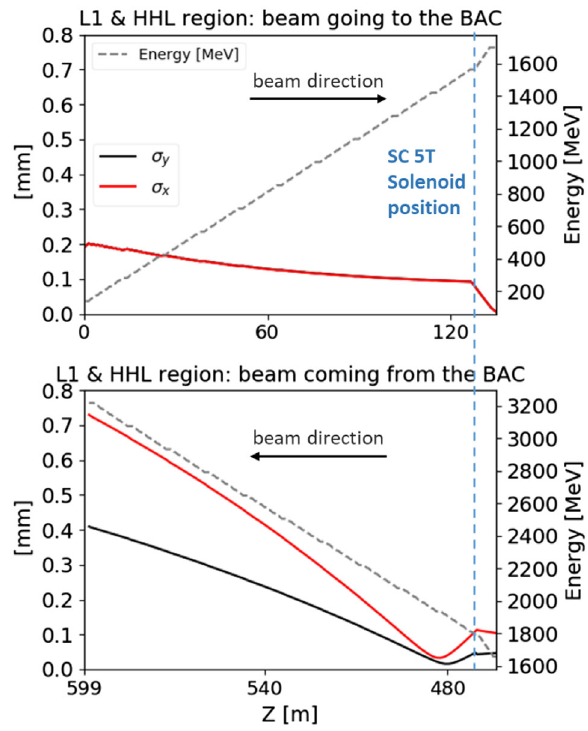
FIG. 4. The upper plot shows the normalized transverse emittance, the rms transverse envelope and the rms bunch length, for a cylindrical symmetry bunch distribution. The lower plot shows the normalized longitudinal emittance and the energy gain. The TESLA cryomodule position is highlighted to show where beam quality parameters are damped and frozen.